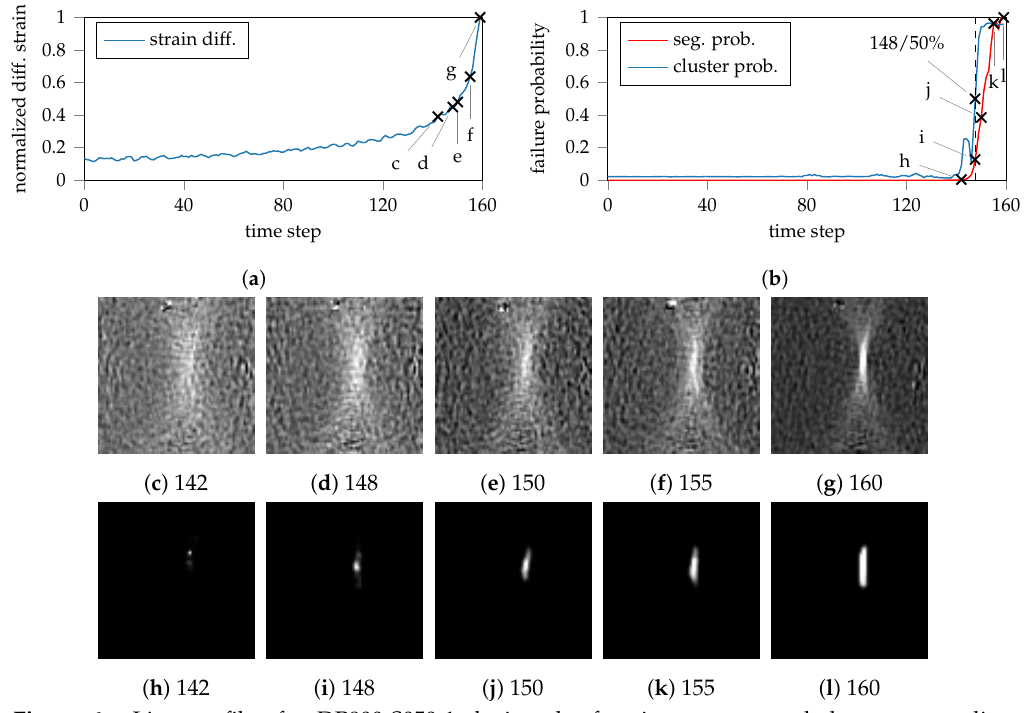
Figure 6. Line profiles for DP800-S050-1 during the forming process and the corresponding probability progression results for the proposed methods on image and pixel scale: ( a ) Progression of the incremental strain development through the maximum. ( b ) Corresponding probability progression through the maximum value of the prediction on pixel scale (seg. prob) together with the cluster result on image scale (cluster prob). Especially in case of the image scale approach, the effect of measurement errors or outliers is emphasized by the premature rise of the failure probability that ultimately should remain lower for a couple of more frames. ( c – g ) Difference strain distributions at multiple time